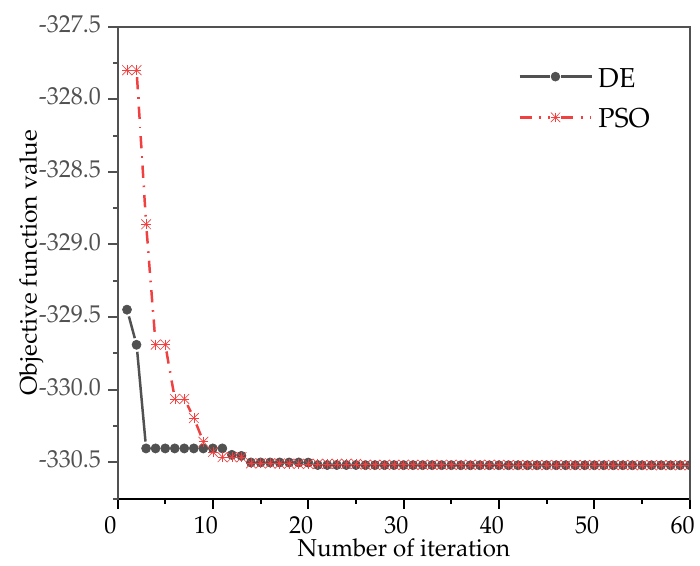
Figure 10. Iterative optimization curve of DE and particle swarm optimization (PSO) algorithms. Table 6. Optimal tooth profile parameters.